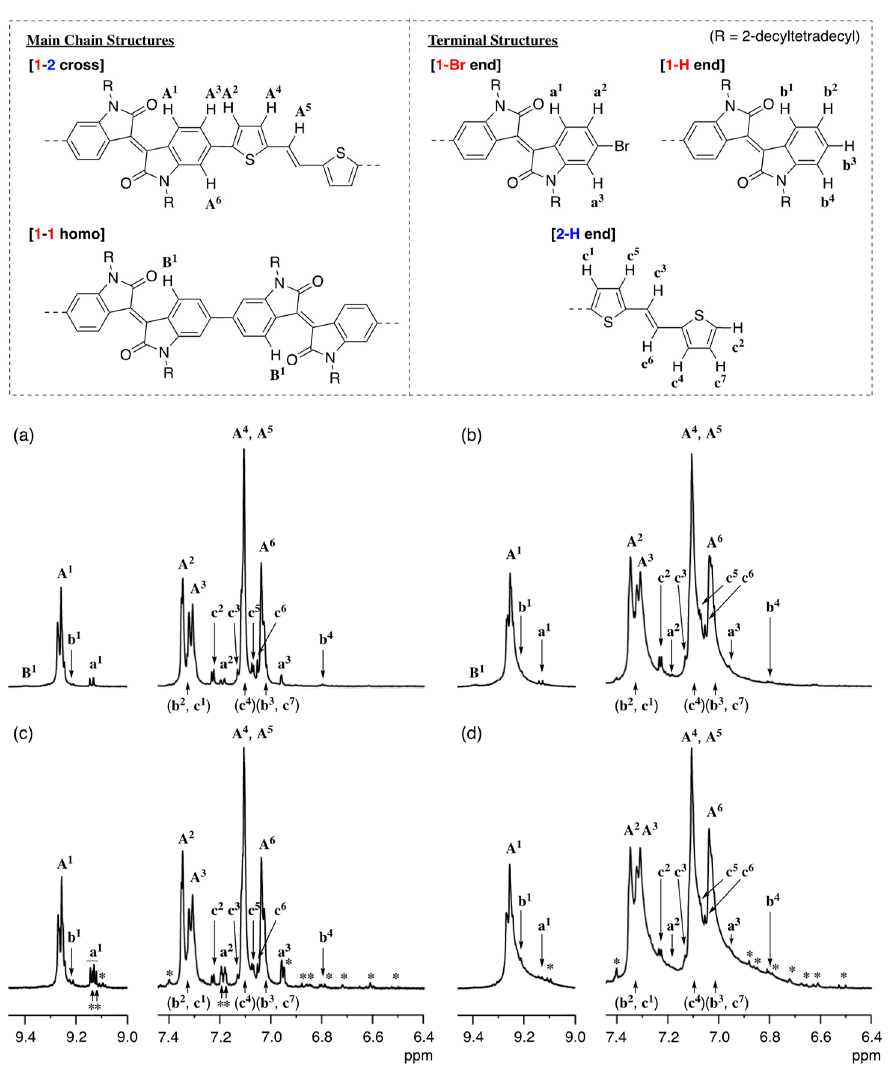
Figure 1. 1 H-NMR spectra of poly( 1 - alt - 2 ) prepared via DArP ( M n = 15,700 ( a ) and M n = 22,700 ( b )) and Migita–Kosugi–Stille cross-coupling polymerization ( M n = 17,700 ( c ) and M n = 24,400 ( d )) in C 2 D 2 Cl 4 at 130 °C (600 MHz). * : unidentified signals.